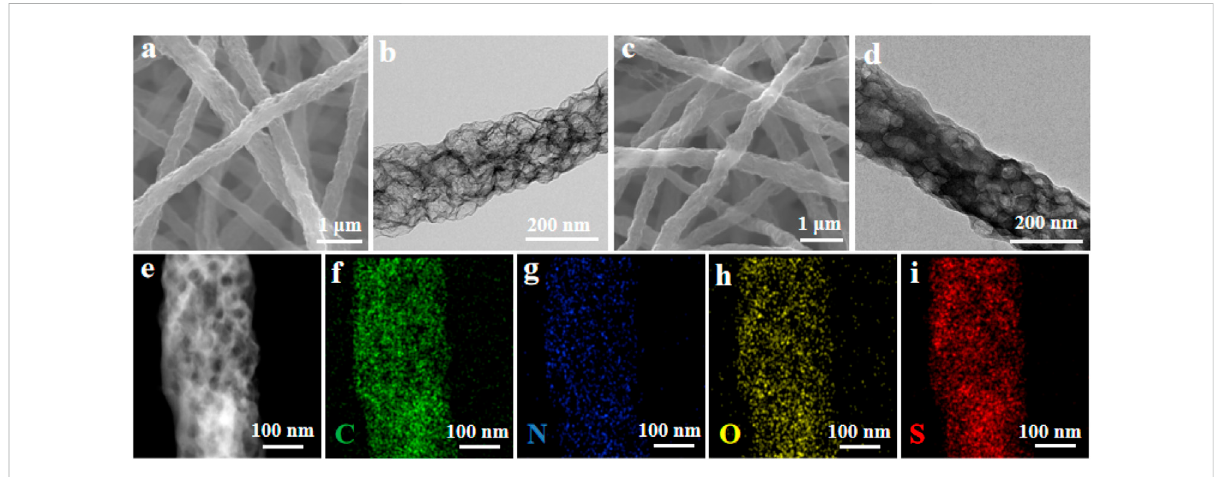
FIGURE 2 (A – B) SEM and TEM images of HPCNFs; (C – D) SEM and TEM images of HPCNFs@S; (E – I) HADDF-STEM image of HPCNFs@S and element mapping of C (F) , N (G) , O (H) , and S (I) .